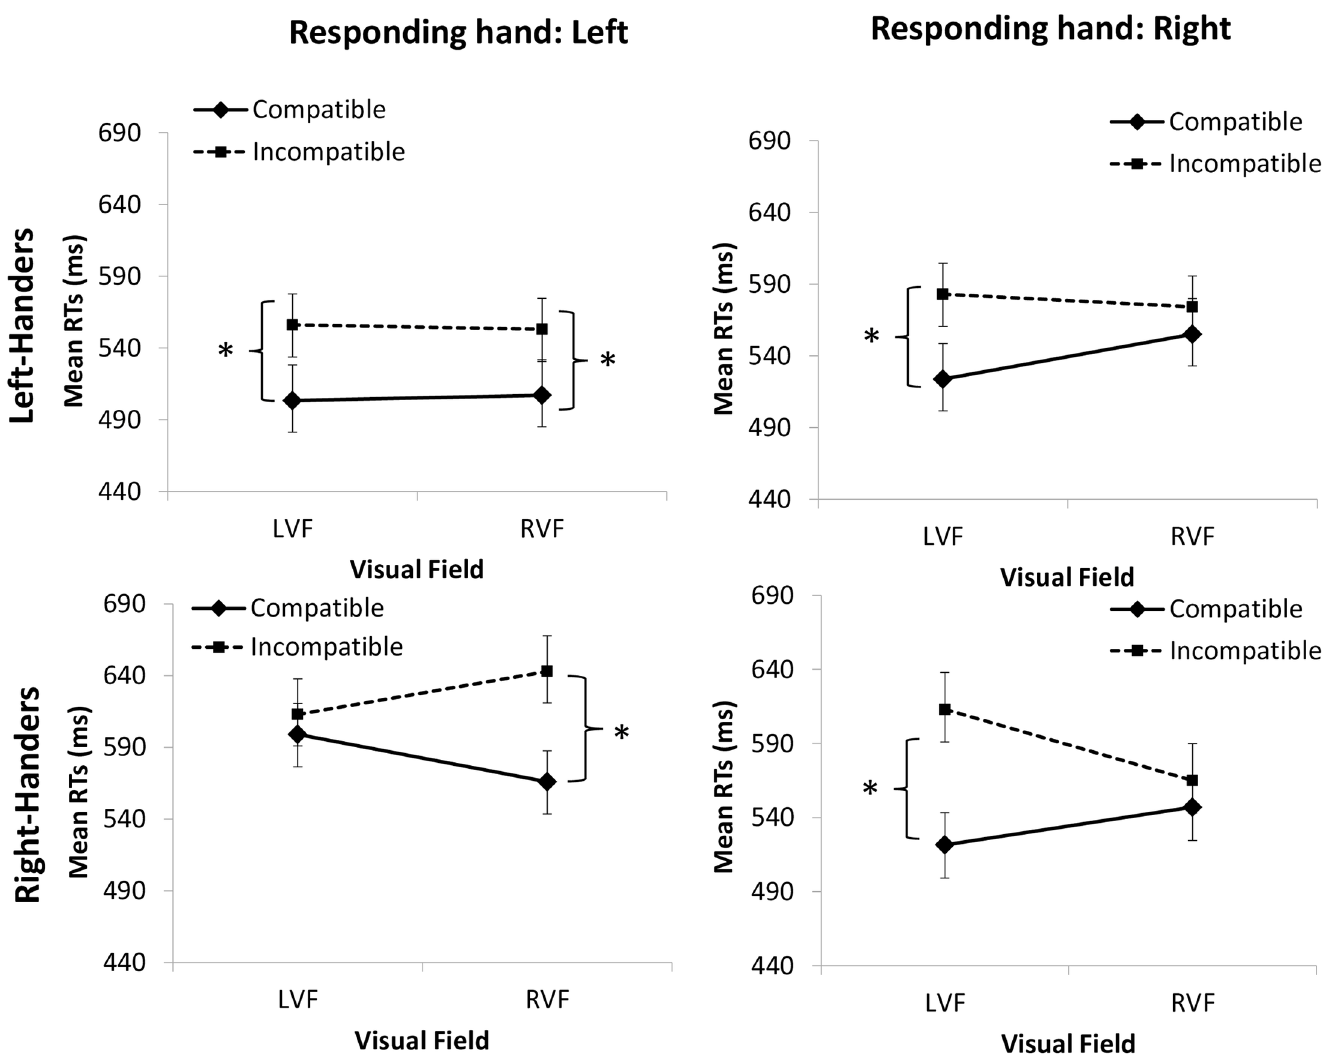
Fig 2. Each panel shows mean RTs as a function of compatibility (compatible and incompatible) and stimulus locations (left and right visual field; LVF and RVF, respectively). Compatibility is defined by the relationship between response and stimulus location; when response side (e.g., left) corresponds to visual field (e.g., LVF), the condition is compatible, and when response side and visual field do not correspond, the condition is incompatible. The responding hand was always positioned to the right (for the right responding hand condition) or to the left (for the left responding hand condition) of the body midline. Panels A and B show results for left-handers for the left and the right responding hand, respectively. Panels C and D show results for the right- handers for the left and right responding hand, respectively. Note that a symmetrical Simon effect was only found for the group of left-handers responding with the left hand (Panel A). Error bars represent standard error of the mean. Stars indicate significant effects ( p <